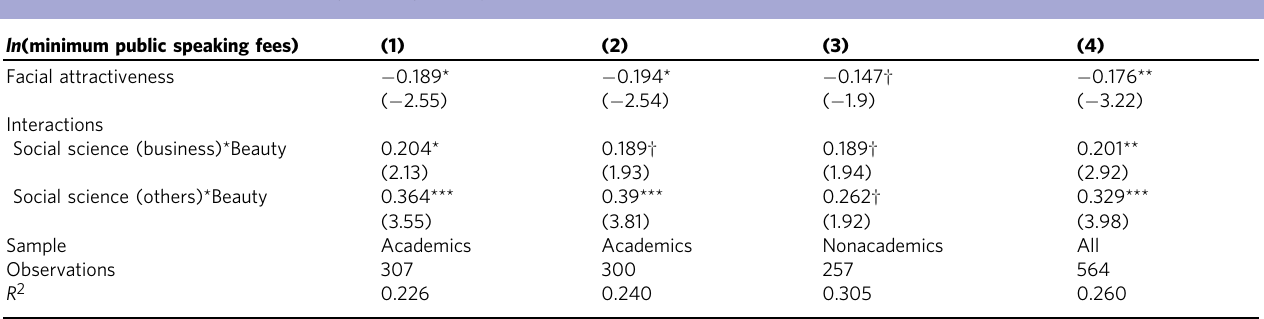
Table 4 Facial attractiveness and public speaking